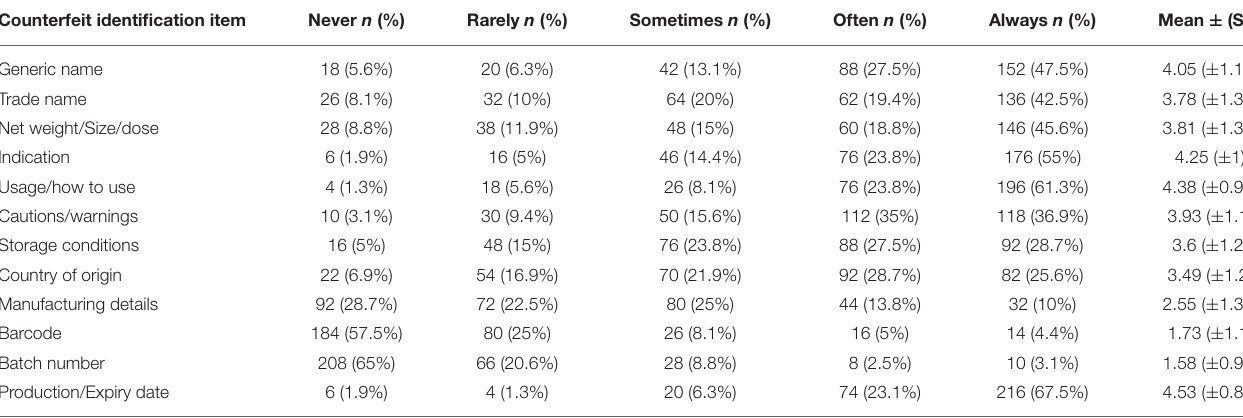
TABLE 3 | Frequency table for counterfeit identification items ( n =